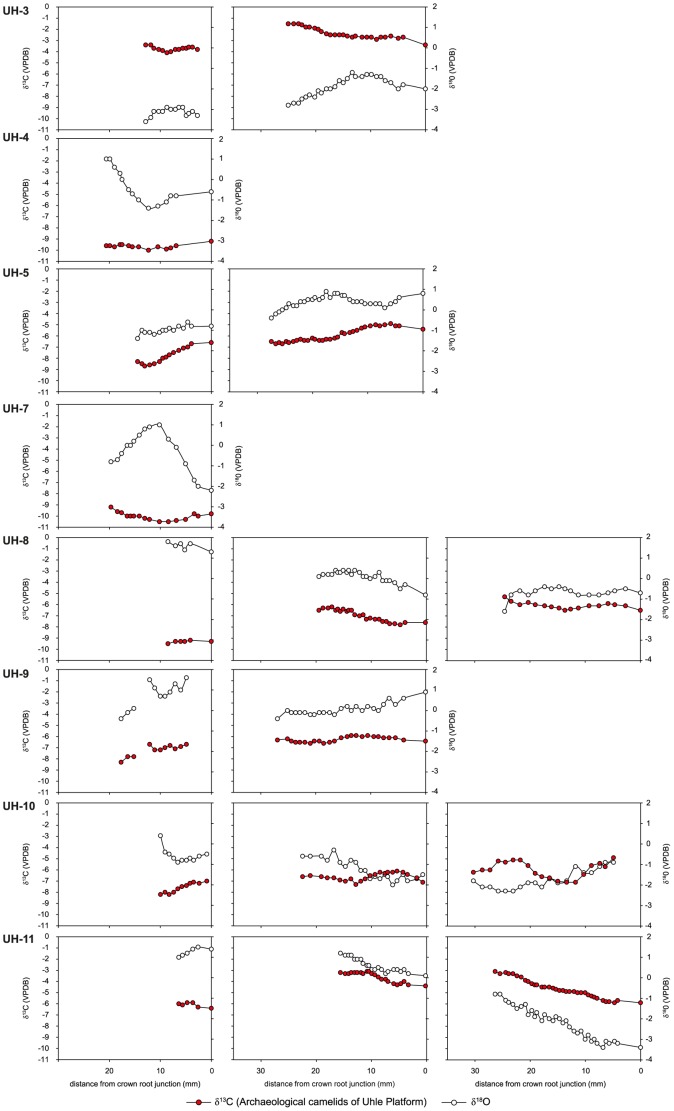
Intra-tooth isotopic composition of enamel structural carbonate of Uhle Platform camelids.Intra-tooth variations in δ13C and δ18O values (‰ VPDB) measured along the molar crowns of archaeological and modern highland domestic camelids and estimation of the contribution of C3 and C4 plants during crown growth. For each specimen, the left graph is for the M1 molar, the middle graph for the M2 molar and the right graph for the M3 molar. On each graph, the left axis refers to δ13Cenamel values and the right to δ18Oenamel values.